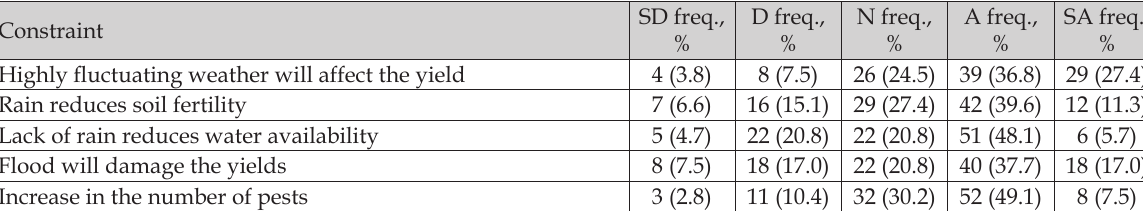
Table 8. Environmental constraints.